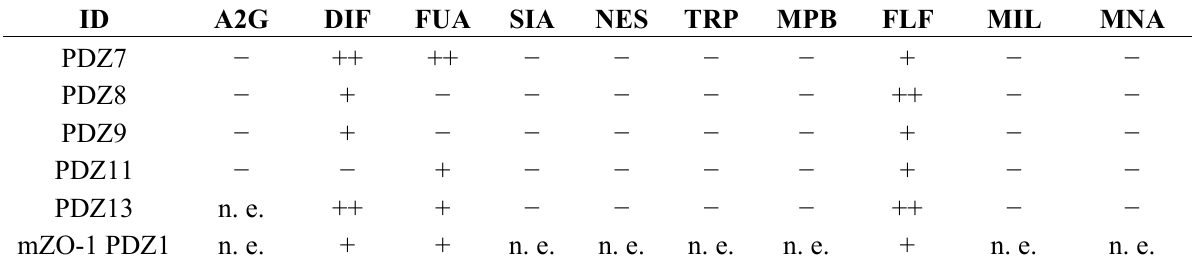
Table 3. Summary of the interaction between PDZ domains and small compounds. The number of plus signs indicates the degree of signal changes. The minus sign indicates no signal change. n. e. indicates that the sample was not examined.